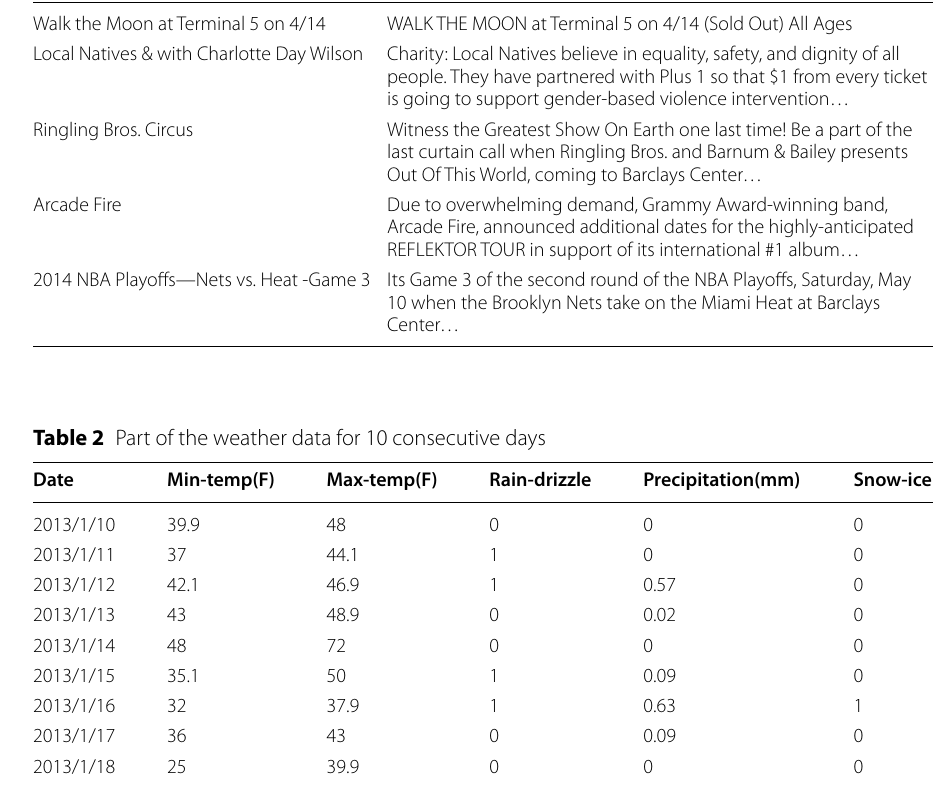
Table 1 Event information acquired from internet Title Description Walk the Moon at Terminal 5 on 4/14 WALK THE MOON at Terminal 5 on 4/14 (Sold Out) All Ages Local Natives & with Charlotte Day Wilson Charity: Local Natives believe in equality, safety, and dignity of all people. They have partnered with Plus 1 so that $1 from every ticket is going to support gender-based violence intervention… Ringling Bros. Circus